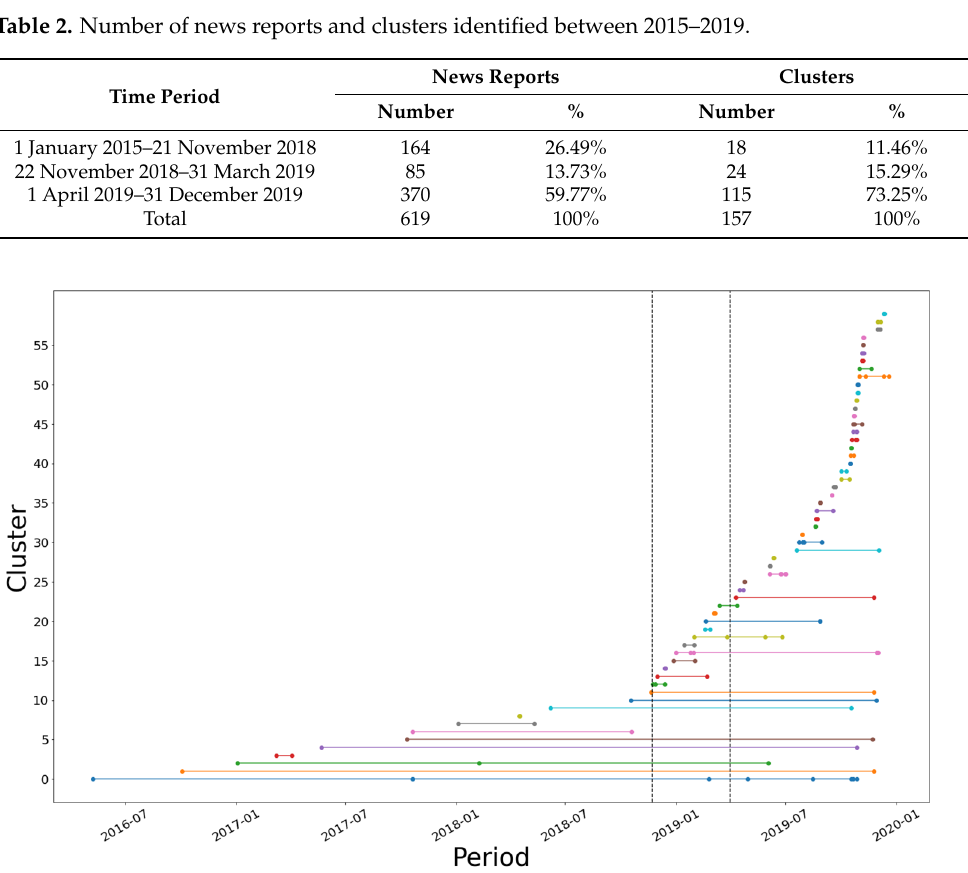
Table 2. Number of news reports and clusters identified between 2015–2019.